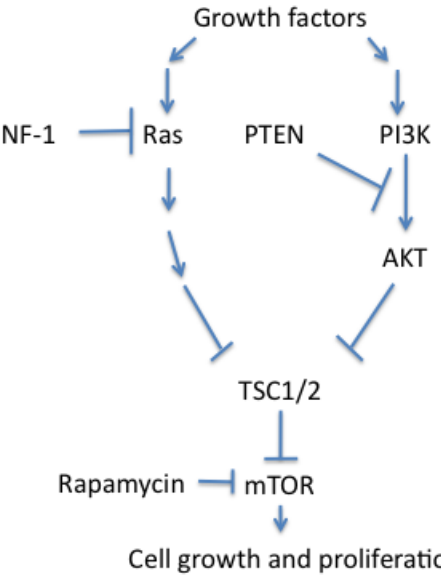
Figure 2. Scheme of mTOR-signaling